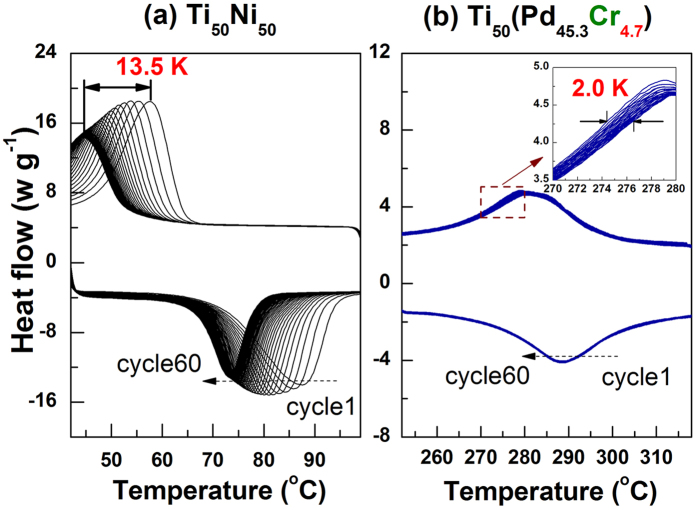
Functional fatigue behavior of bulk alloys.Compilation of 60 DSC cycles plotted for (a) Ti50Ni50, (b) Ti50Pd45.3Cr4.7. The inset in (b) enlarges the shift of the DSC curves for Ti50Pd45.3Cr4.7. The shift in Ti50Ni50 of 13.5 K is much larger than that in Ti50Ni50 of 2.0 K, indicating a significant improvement in functional fatigue.